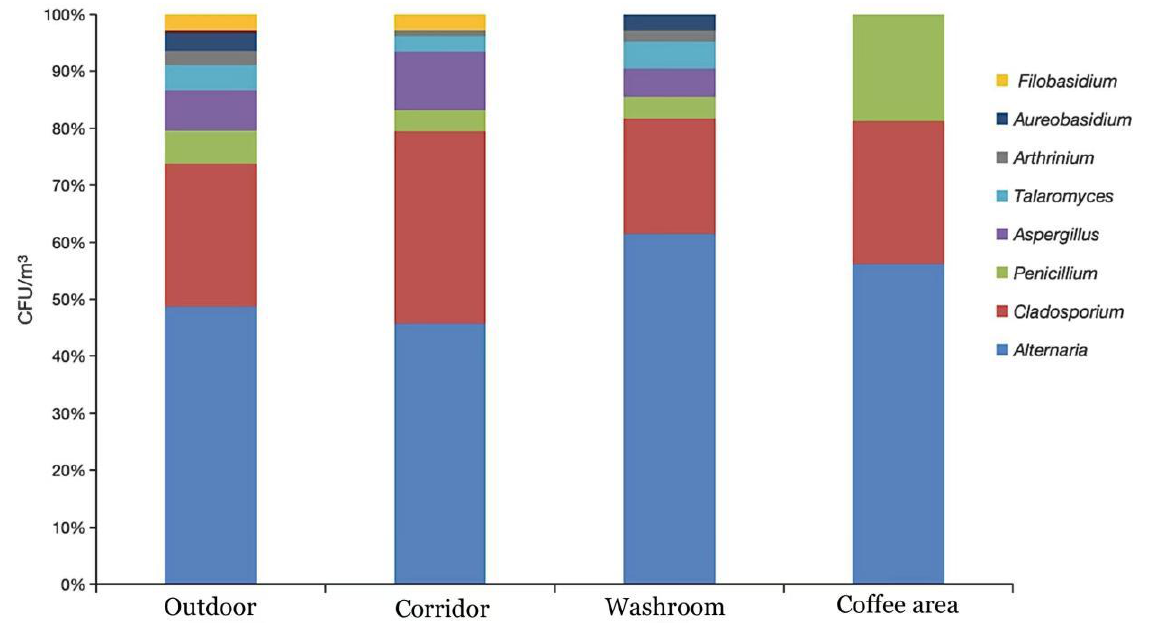
Figure 6. Taxonomic profiles and concentrations of main fungal genera in 4 sampling environments.